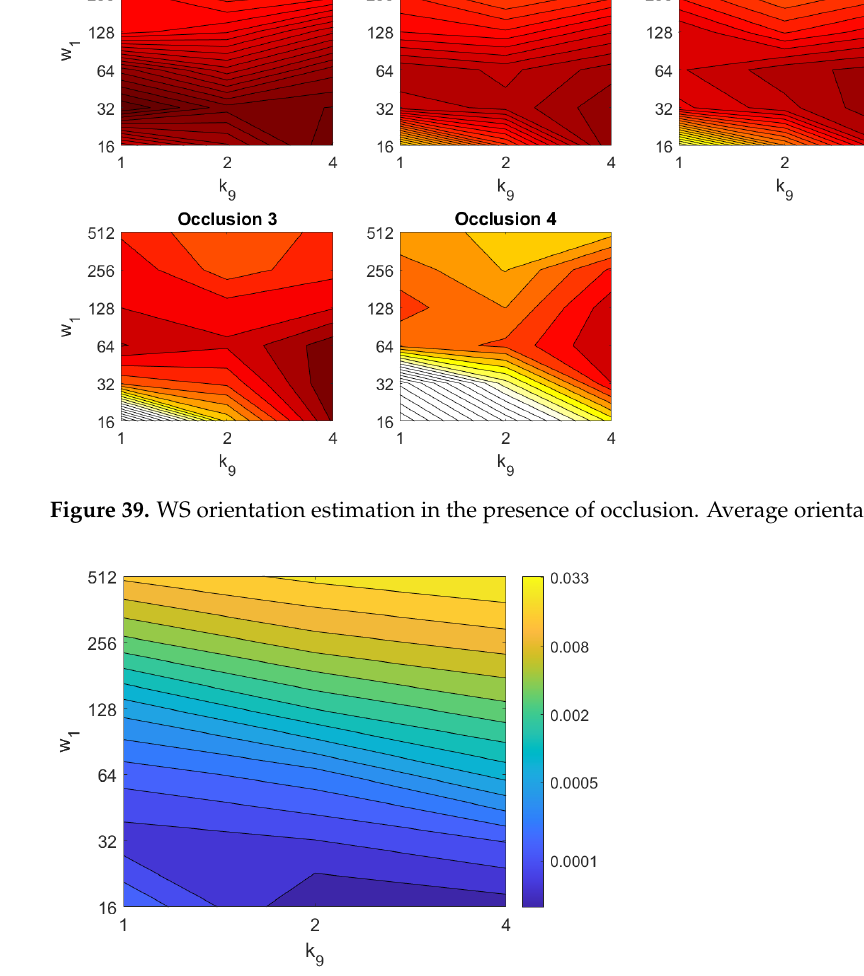
Figure 40. WS orientation estimation. Average computation time